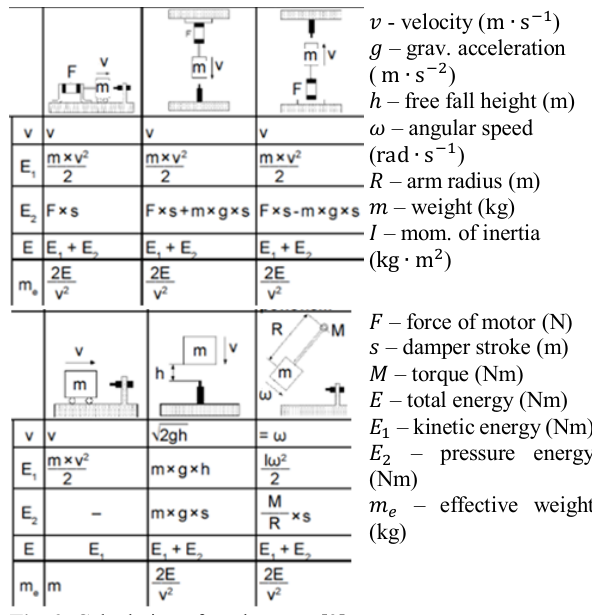
Fig. 3. Calculation of total energy